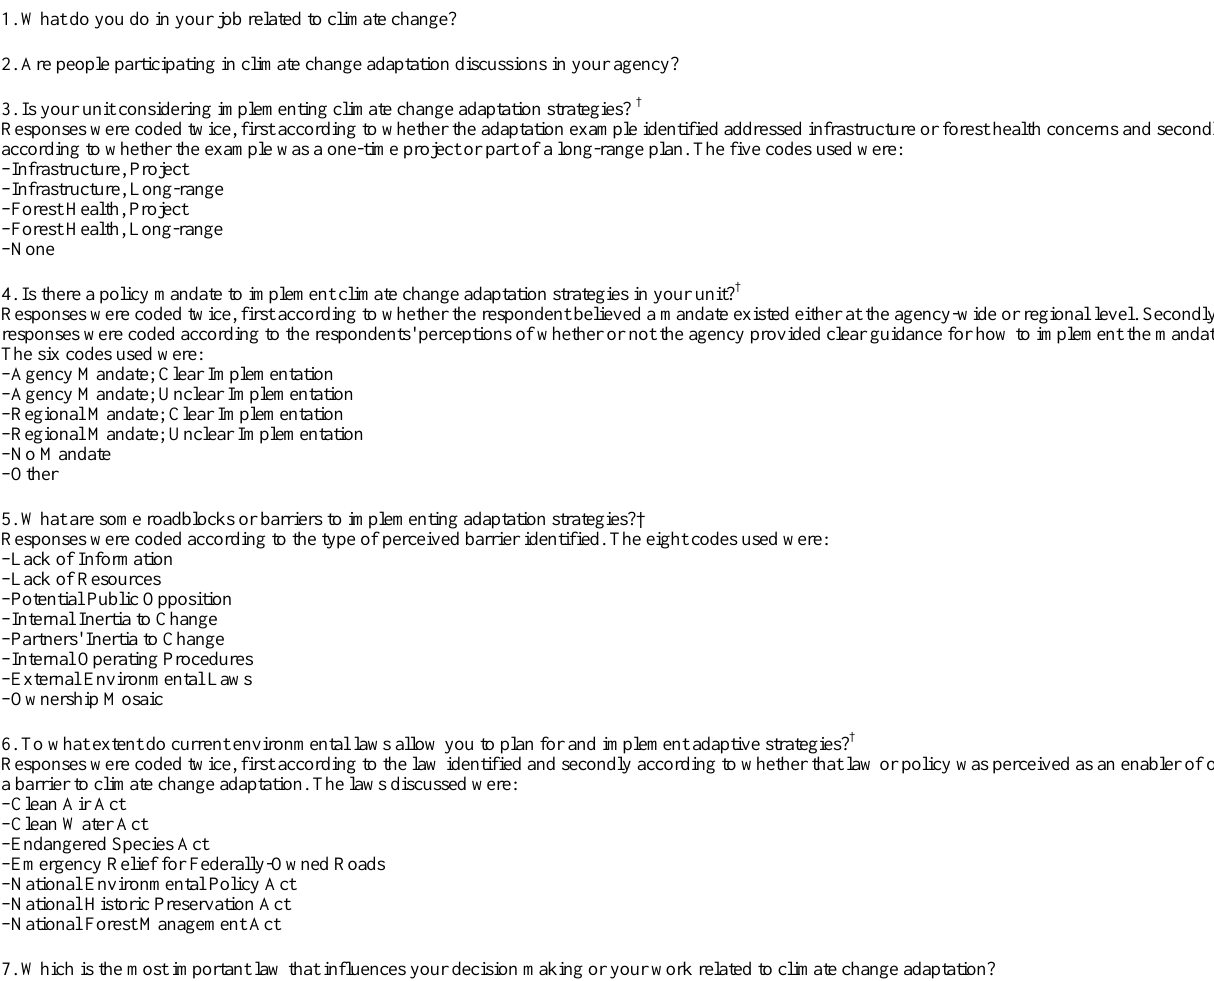
Table 1 . Interview guide